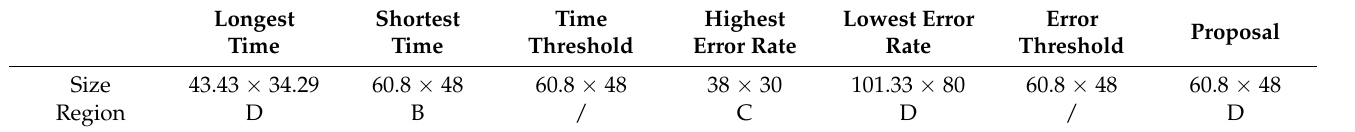
Table 3. Design suggestions for selecting spatial targets under visual conditions.